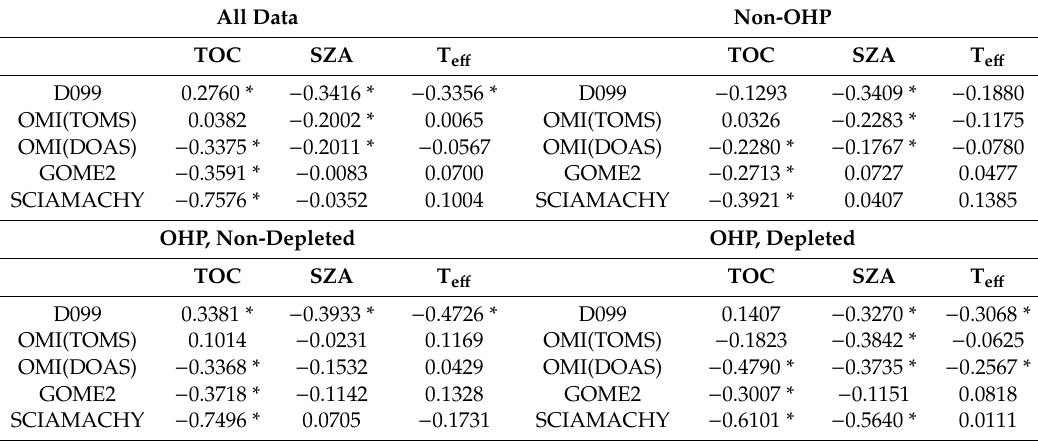
Table 3. Partial correlation between the explanatory variables and the ratio between the B199 and the studied data sources at the Marambio Base for the period 2011–2013. Asterisks indicate statistically significant partial